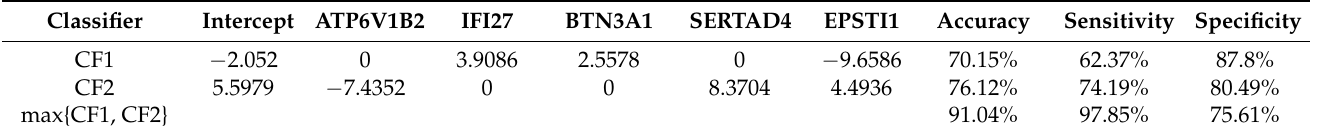
Table 4. First dataset: Characteristics of the top-performing five-gene classifier. CF1 and CF2 are the first and second individual classifiers for data of COVID-19 patients vs. other viral infection ARIs, but not non-viral infection patients.